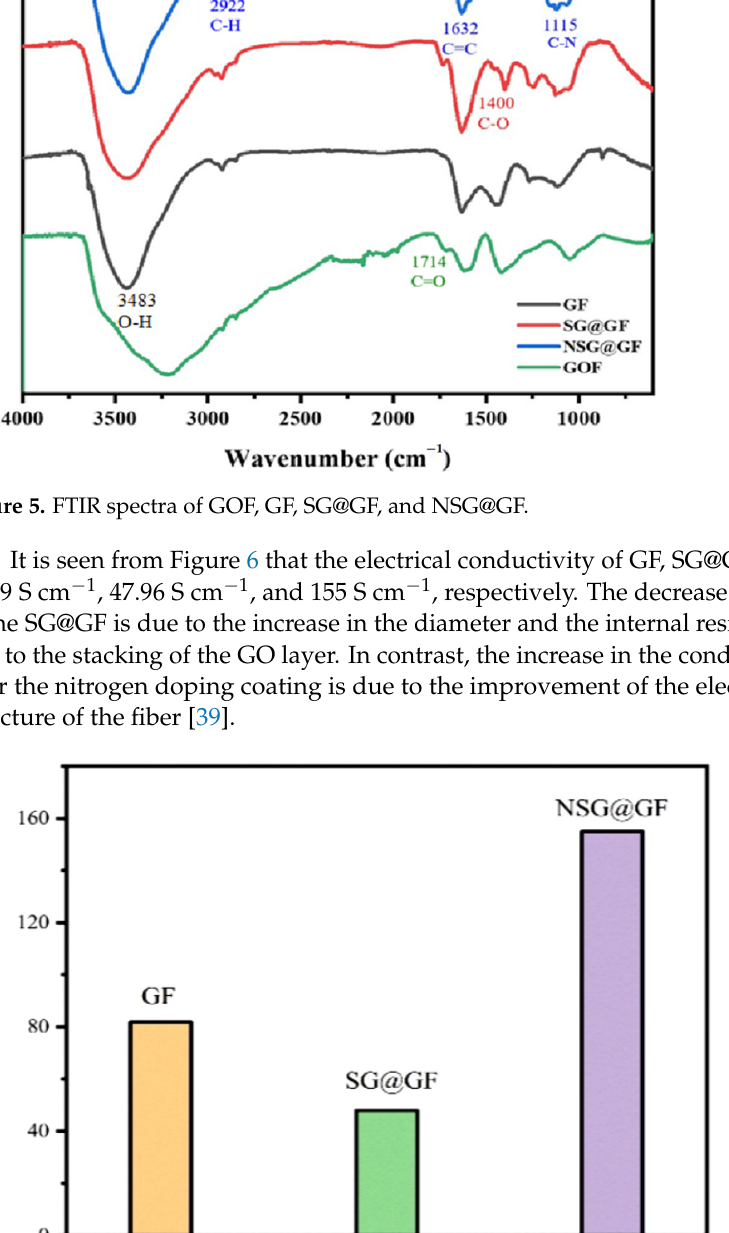
Figure 4. XPS spectra for N1s of NSG@GF.